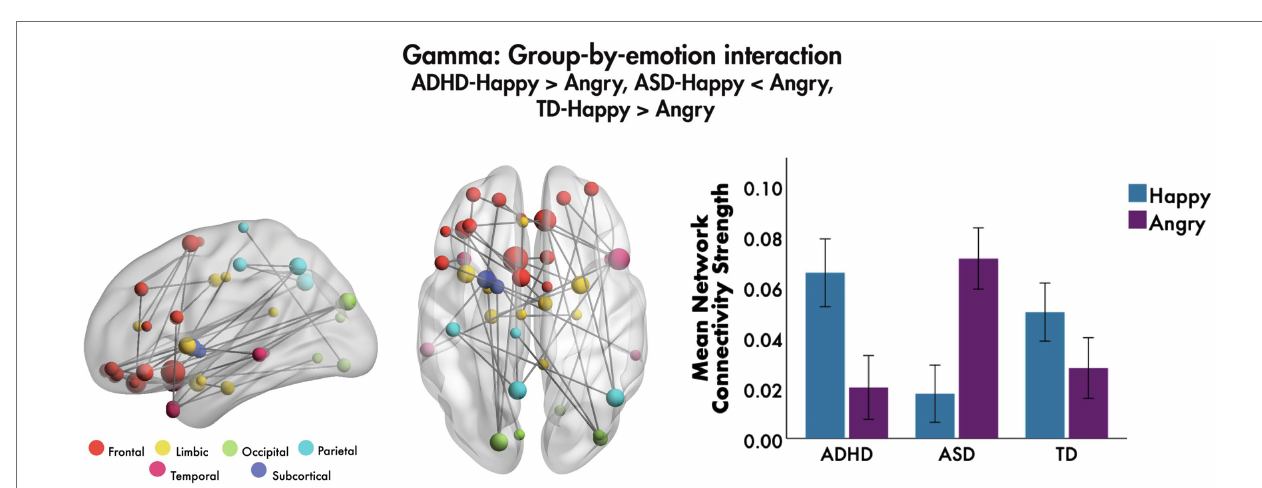
FIGURE 3 | Group-by-emotion interaction, 200–400 ms to emotional faces, following the onset of non-target trials. A significant group-by-emotion interaction was seen in the gamma band to happy and angry faces, indicating that functional connectivity network strength in each group is modulated by the valence of the emotional faces. The glass brains represent the network, where node size is scaled by degree. The mean network connectivity strength for this network by emotion is plotted for each group in the bar graph (error bars represent 95% confidence intervals).